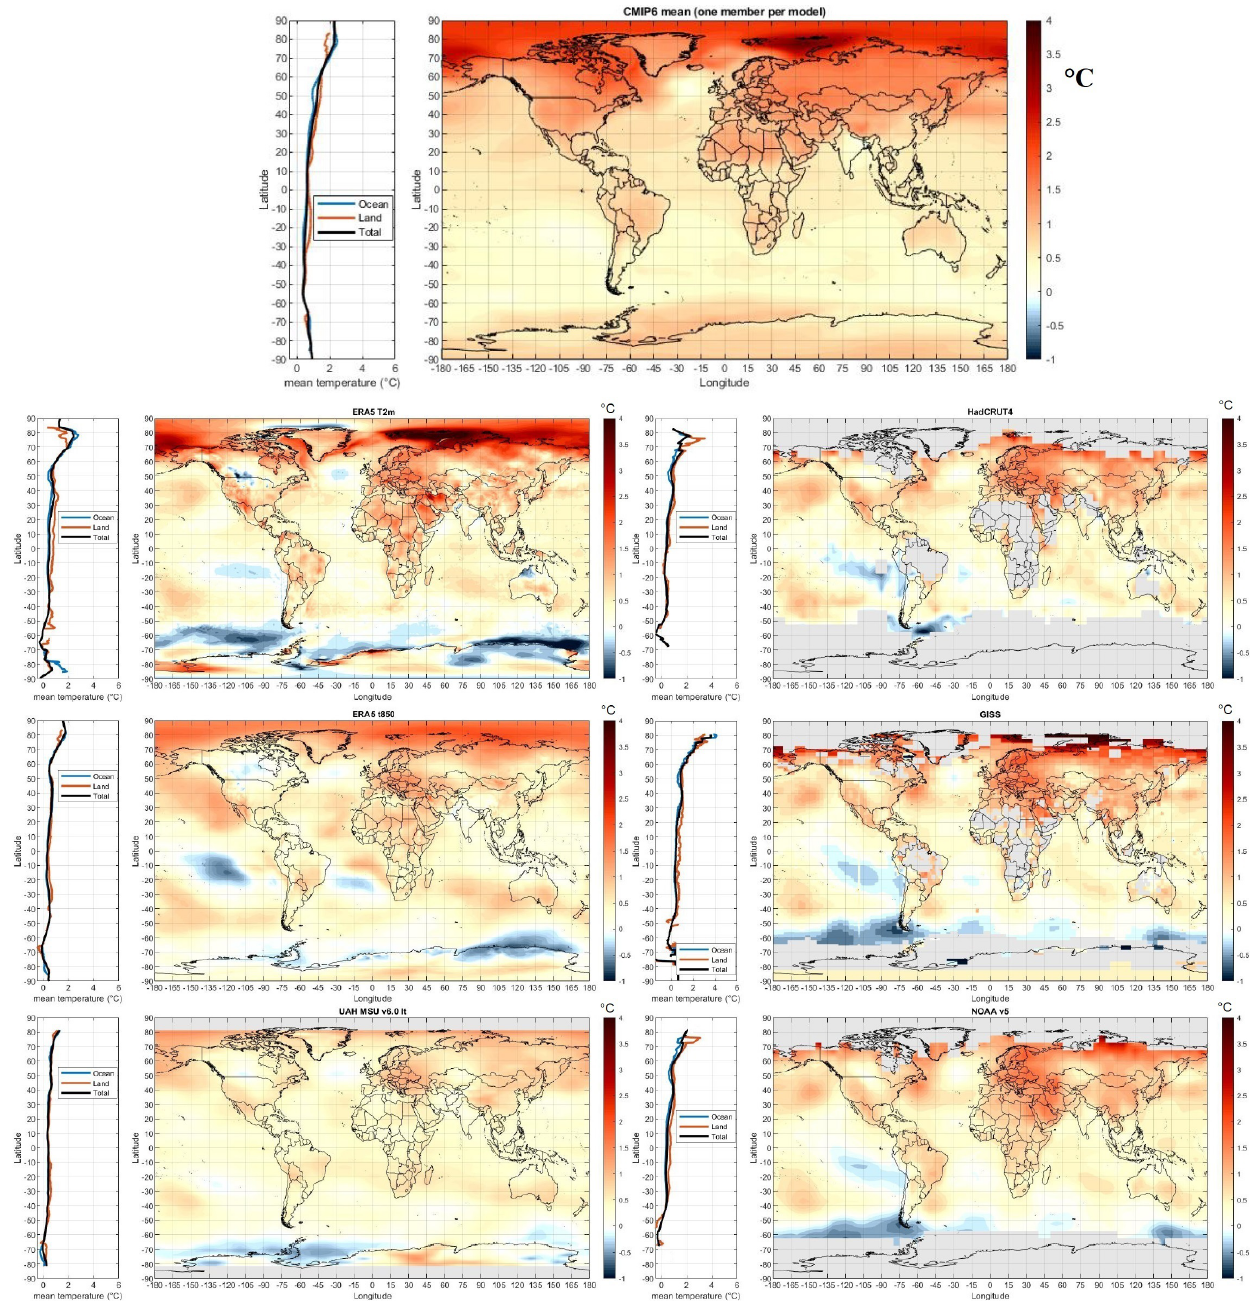
Figure 3. Regional distribution of warming patterns from 1980–1990 to 2011–2021 for the CMIP6-tas ensemble average record and the six temperature records: ERA5-T2m, ERA5-850mb, and UAH MSU v6.0 Tlt, HadCRUT4, GISTEMP 250km, NOAA v5. Gray areas indicate missing